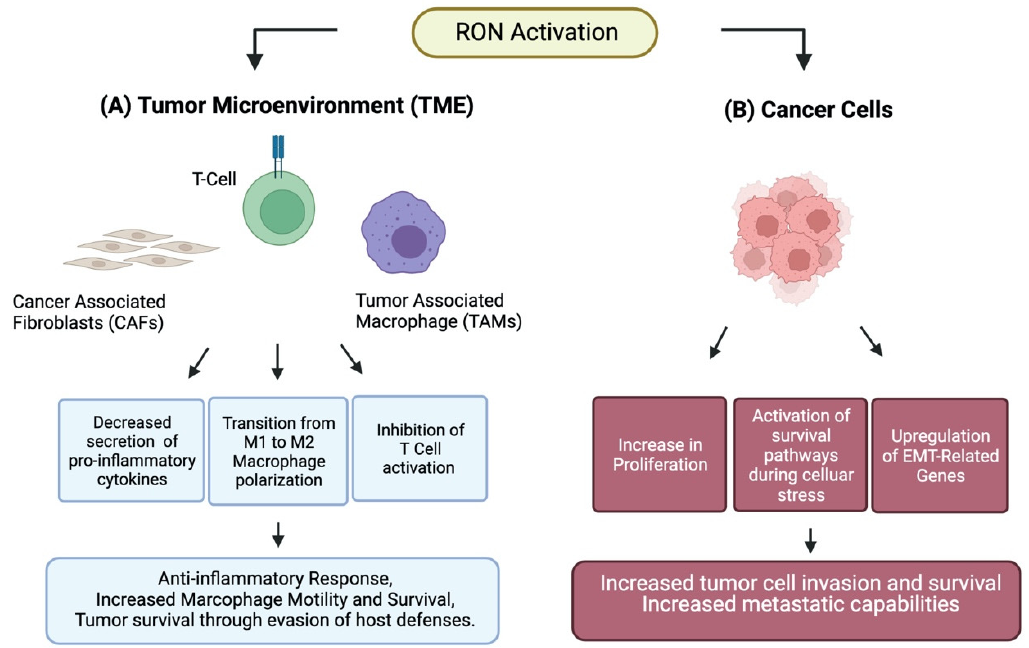
Figure 3. ( A ) RON activation in the tumor microenvironment elicits alteration in cancer associated fibroblasts, T-cells, and tumor associated macrophages culminating in a tumor permissive environment. ( B ) RON activation in cancer cells leads to increased proliferation, activation of survival pathways and increased stress tolerance, as well as upregulation of epithelial to mesenchymal related (EMT) genes.